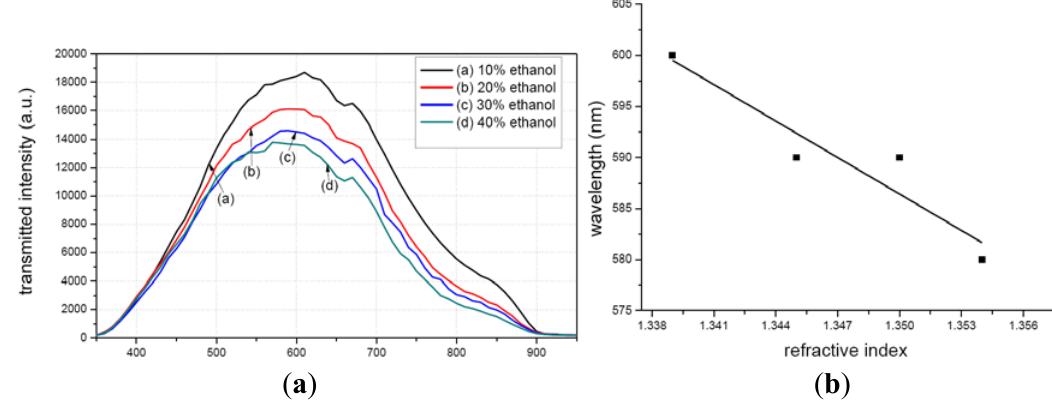
Figure 14. Refractive index sensitivity test. ( a ) Transmittance of the modified fiber by MPTMS; ( b ) Relationship between wavelength and refractive